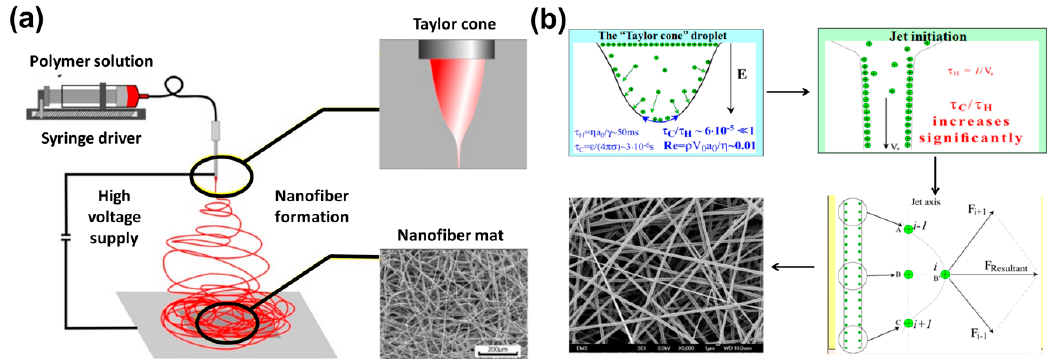
Figure 4. Schematic of ( a ) electrospinning and ( b ) the interaction of polymer and applied electric field is shown. Reproduced with permission from Ref. [84]. Copyright Springer Nature 2018.